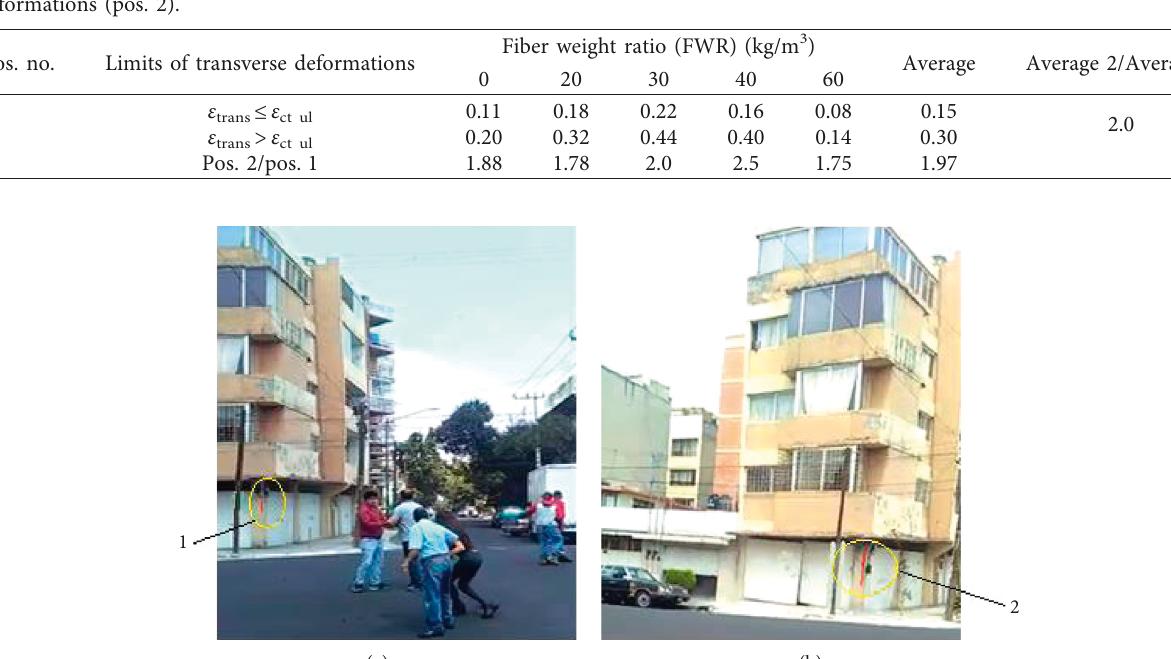
Average values. ∗ Pos. No.